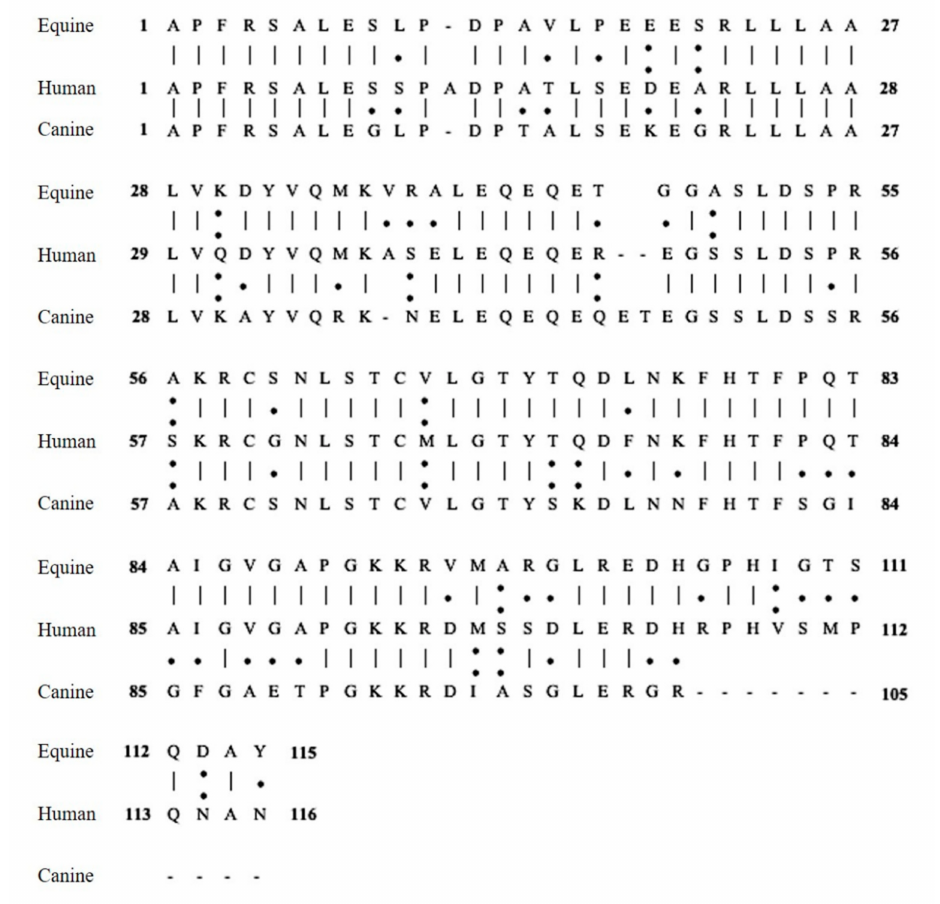
Figure 3. Alignment of the amino acid sequences of equine–human–canine procalcitonin. Numbers indicate amino acids. The symbols between the amino acid sequences represent conserved sequences ( | ), conservative mutations that are di ff erent amino acids with similar biochemistry proprieties such as hydrophobicity, size and charge (:), semi-conservative mutations ( · ), and gaps